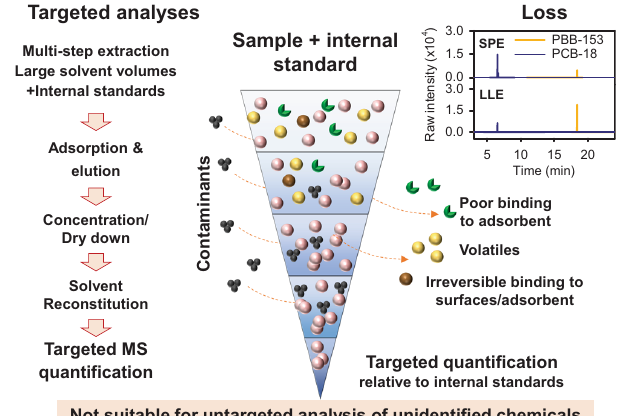
Fig. 1 A new analytic approach is needed to support health research on extensive and diverse chemical exposures of humans. Targeted analyses for a limited number of chemicals are available using mass spectrometry. Left: Multistep processing is used for targeted detection of low abundance of environmental chemicals. MS: mass spectrometry. Right: Recovery of chemicals differs by sample-preparation procedures. Standard reference material NIST SRM-1958 was analyzed using solid-phase extraction (SPE) and liquid – liquid extraction (LLE). Middle: Addition of stable isotopic internal standards during the procedure allows correction for variability of recovery due to losses during processing. The multistep processing has potential for contamination at each step, decreases sample throughput, increases cost, and is not suitable for untargeted analysis because there is no way to correct for variable recovery. Source data are provided as a Source Data fi le for chromatography of SPE and LLE for polybrominated biphenyl (PBB)-153 and polychlorinated biphenyl